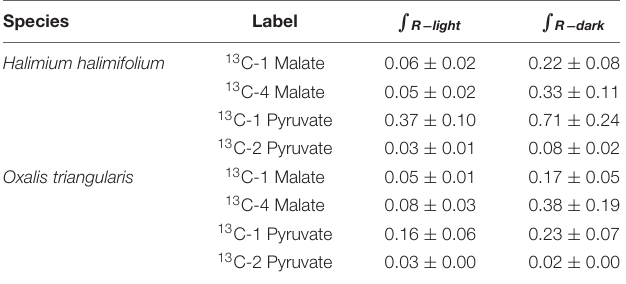
TABLE 1 | Sums of 13 CO 2 respiration ( (cid:82) R ) derived from different 13 C-labeled substrates. Species